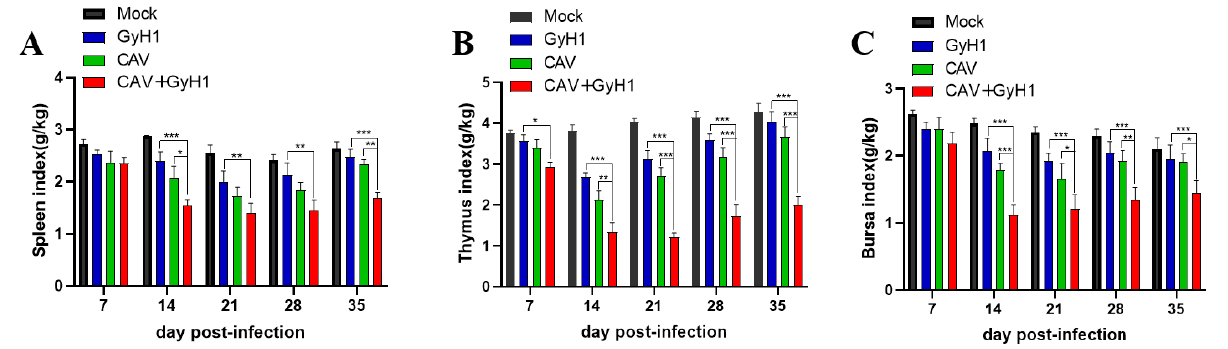
Figure 4. Dynamic changes of immune organ index. ( A ) Spleen index. ( B ) Thymus index. ( C ) Bursa of Fabricius index. Immune organ index = Immune organ weight (g)/live total chicken weight (kg). * , p < 0.05; **, p < 0.01; ***, p < 0.001, (Student’s t -tests).